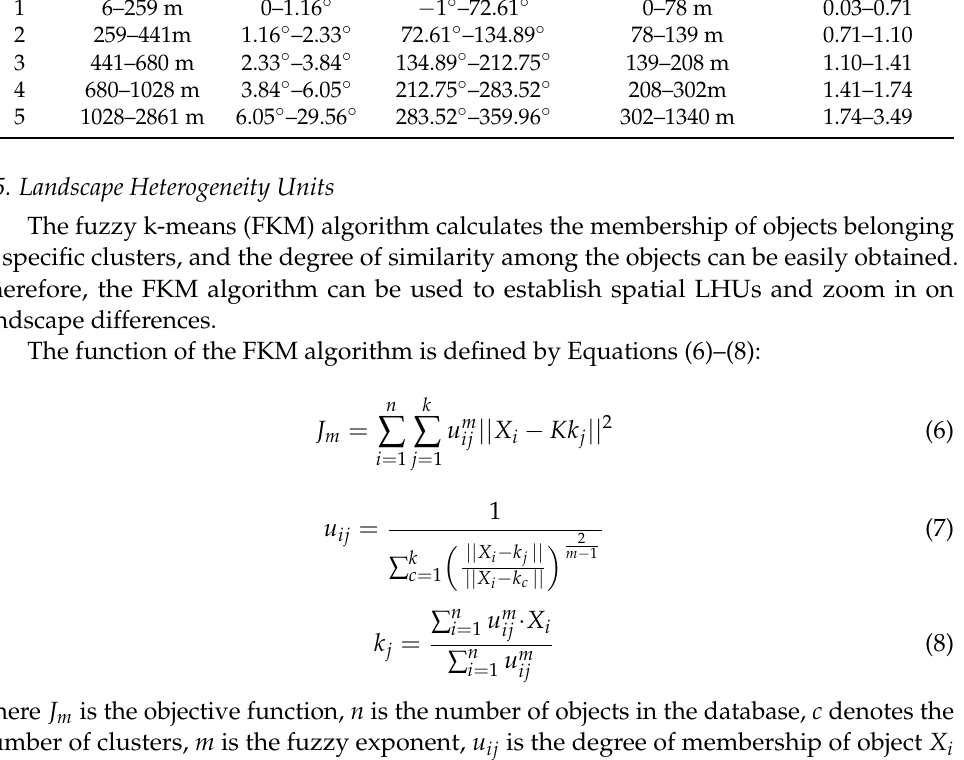
Table 1. Classification of altitude, aspect, slope, landform relief, and terrain niche gradients. Level Altitude Slope Aspect Landform Relief Terrain